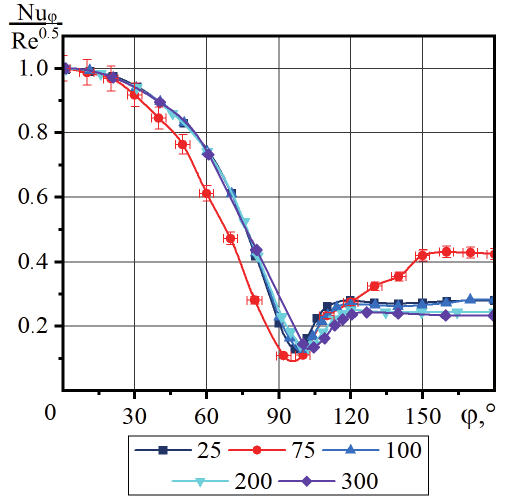
Figure 9. Distribution of the local Nusselt number over the cylinder surface: the legend shows temperature differences ∆ T , K (75—our data, other—data by Jogee et al. [11]).